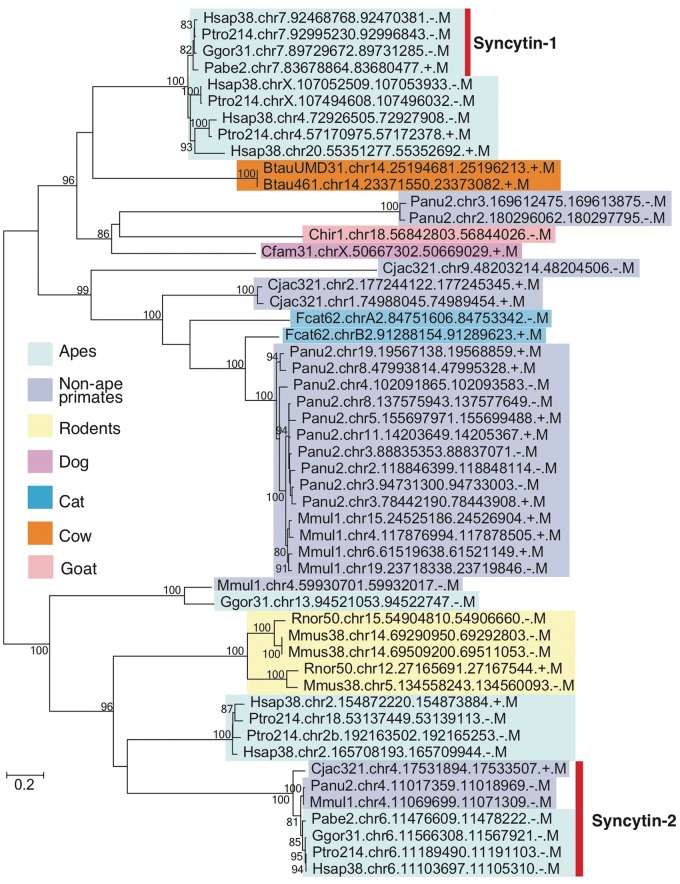
Phylogenetic tree of syncytin-1 like sequences. All sequences over 400 amino acids were extracted from BLASTP hits with e-values <e-40, and the tree was built with RAxML (31) with substitution model (JTT + G + I) determined by ProtTest3 (32). Bootstrap values are shown on the node (1,000 replicates). Known syncytin-1 and -2 genes in primates are indicated by the bar on the right. External nodes show EVE IDs (see Table 2 as well).